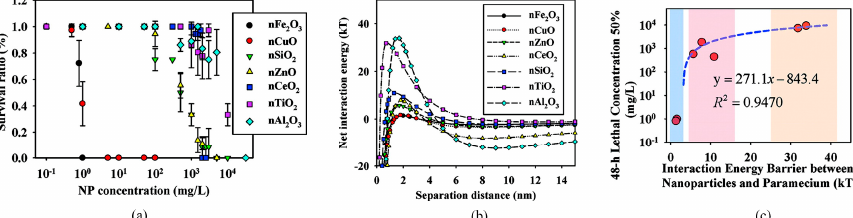
Figure 3. Surface interactions affect the toxicity of metal oxide NPs toward Paramecium : ( a ) survival ratios of P. multimicronucleatum after 48 h of exposure to NPs; ( b ) net interaction energy profiles between NPs and P. multimicronucleatum ; ( c ) relationship of the magnitude of energy barrier and the 48-h LC 50 of metal oxide NPs to P. multimicronucleatum (reproduced with permission from [213], Copyright American Chemical Society, 2012)